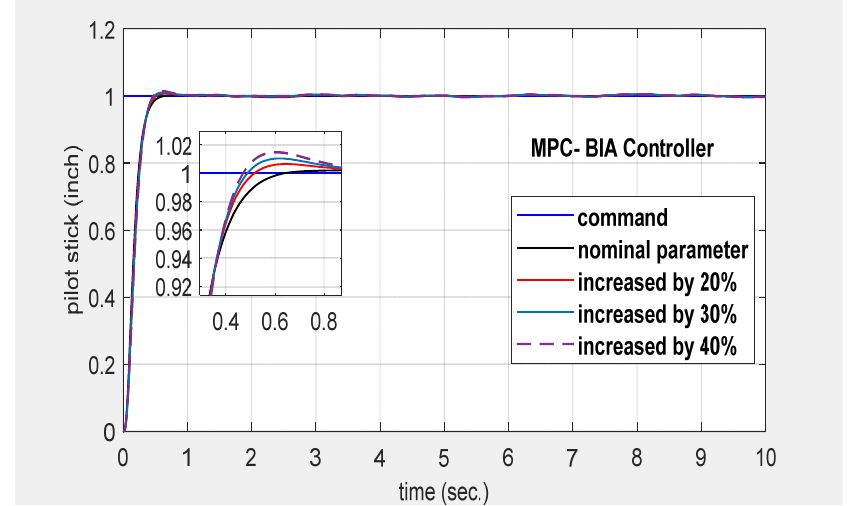
Figure 24. System response based MPC-BIA with parameters perturbation.